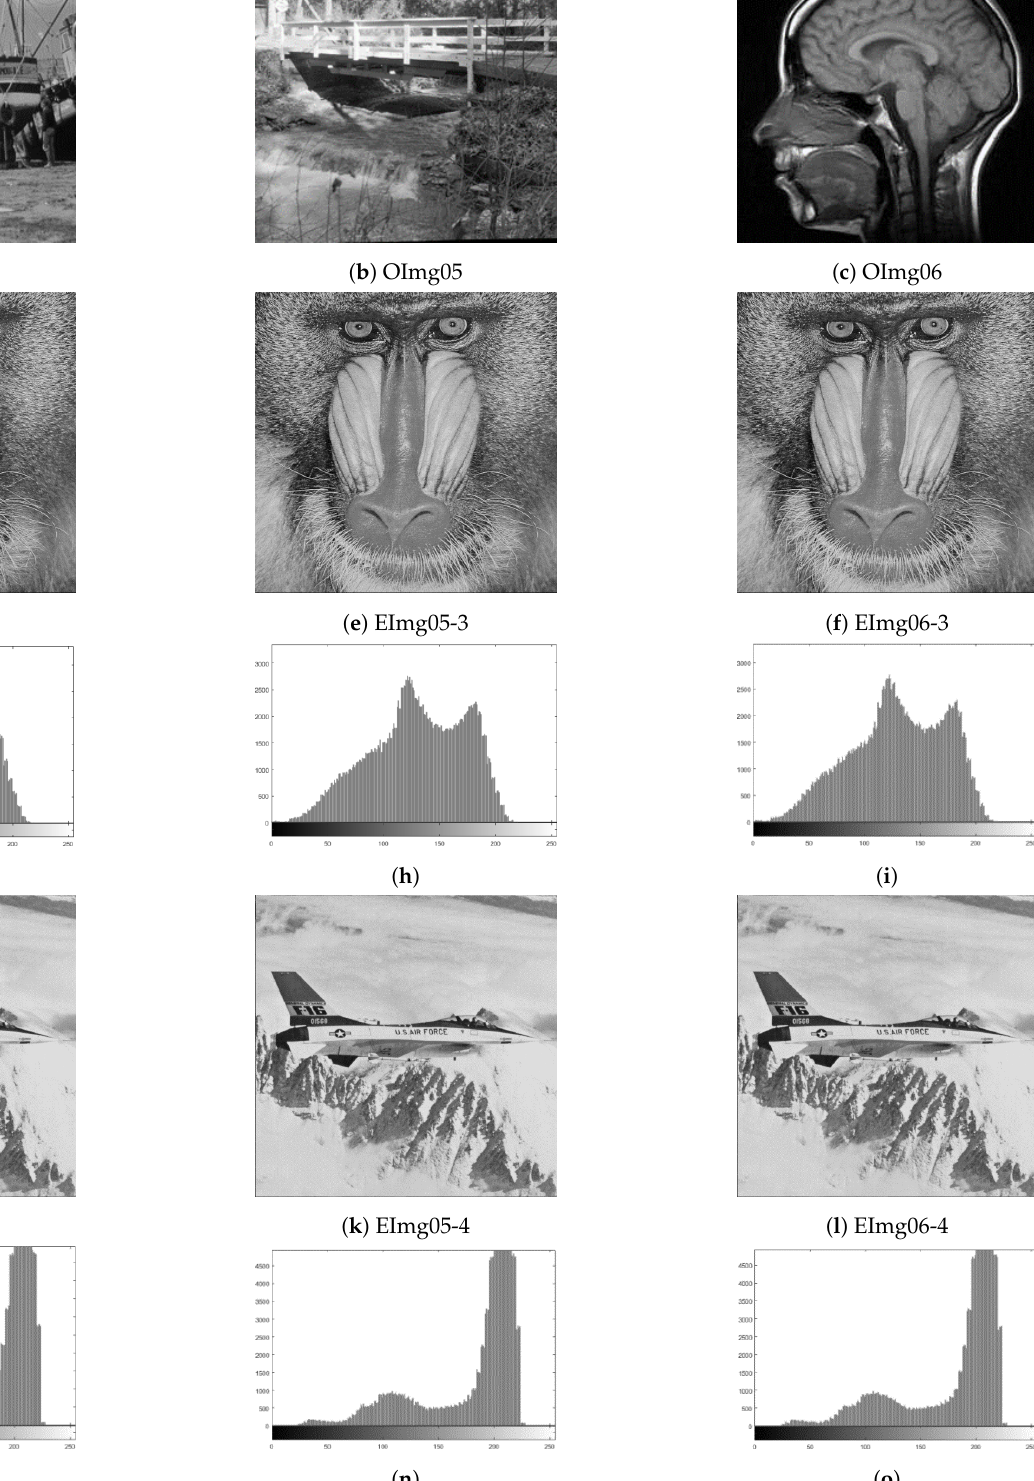
Figure 6. Outcomes of simulation tests for pairings of original and reference greyscale images in the dataset presented earlier in Figures 3 and 4. The original images are presented in the first row ( a – c ), while their encrypted versions with the Baboon (RImg03) image as reference image are presented in the second row ( d – f ). Third row ( g – i ) presents histograms of the encrypted versions of these images. Similarly, the fourth row ( j – l ) presents encrypted versions of the original images with Plane (RIm04) image as reference image, and their respective histograms are presented in the last row ( m – o